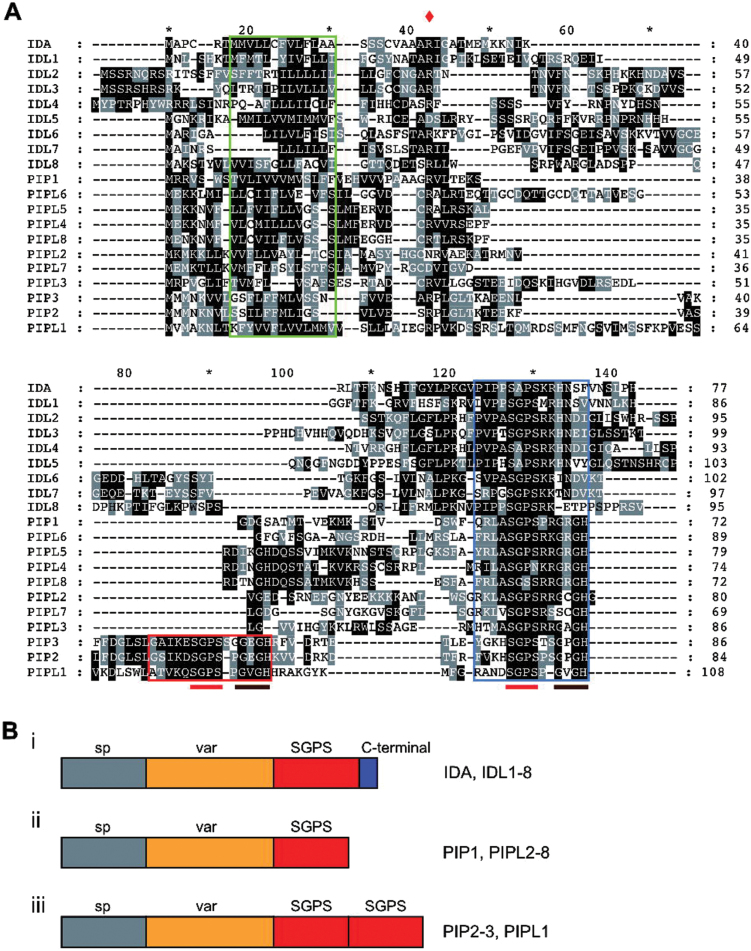
The IDA/IDL and PIP/PIPL peptide families. (A) Protein alignment based on full-length sequences of the IDA/IDL/PIP/PIPL proteins. The green box indicates the SP, the blue box indicates the C-terminal putative peptide ligand motif and the red box indicates the second ligand motif identified in PIP2, PIP3 and PIPL1. The conserved arginine following the predicted SP is marked by a red diamond. The SGPS and GxGH motifs are indicated by red and brown bars below the alignment, respectively. (B) Schematic representation of the proteins in the IDA/IDL and PIP/PIPL peptide families. Grey boxes (marked with ‘sp’) represent the SP sequences identified by SignalP 4.1, orange boxes (marked with ‘var’) indicates a variable region with little homology, and red boxes represents the conserved, C-terminal EPIP domain known to be the active part of the IDA peptide indicated by the conserved core motif SGPS. The IDA and IDL proteins possess a C-terminal, variable sequence (i). This non-conserved sequence is not found among the PIP/PIPLs (ii). PIP2, PIP3 and PIPL1 contain two tandem SPGS motifs (iii).